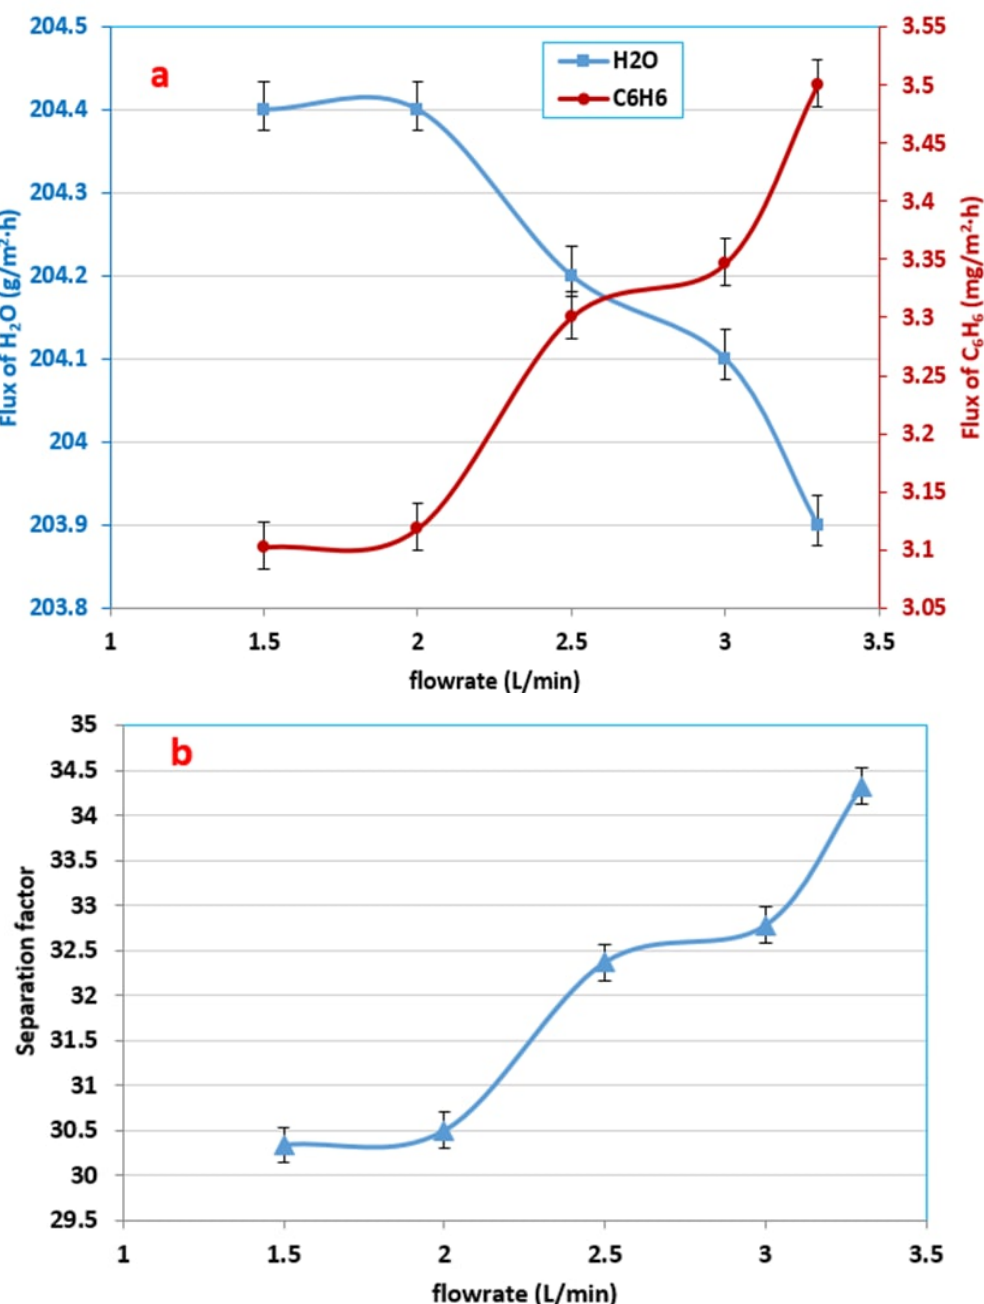
Figure 6. Effect the feed flow rate on ( a ) the fluxes of benzene and water and ( b ) the separation factor at a 500 ppm initial benzene feed concentration and a 30 °C feed temperature. at a 500 ppm initial benzene feed concentration and a 30 ◦ C feed